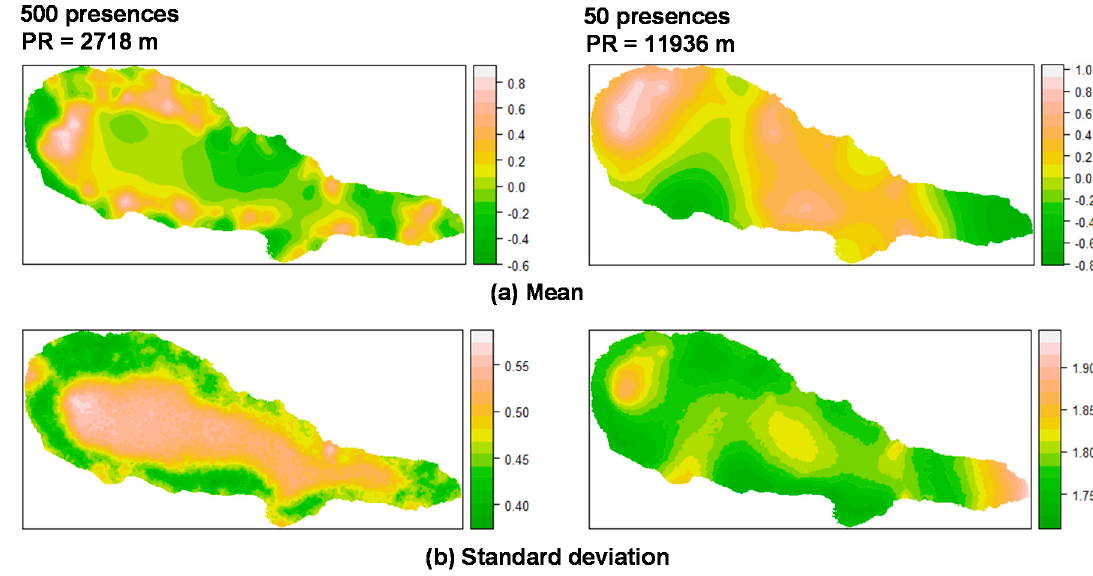
Figure 1. Summary of the spatial random effect (Gaussian random field) for the best mixed effects models and their reduction for P. undulatum in Pico Island. Mean ( a ); Standard deviation ( b ). PR: Practical range.